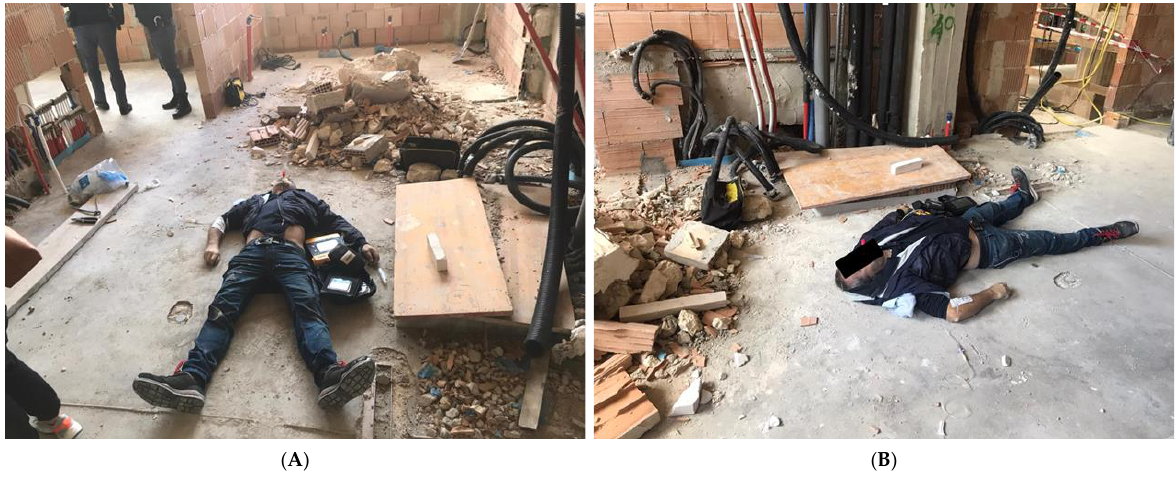
Figure 1. ( A - B ) Overview of the first patient reported. (A) frontal view; (B) lateral view. Figure 1. ( A , B ) Overview of the first patient reported. ( A ) frontal view; ( B ) lateral